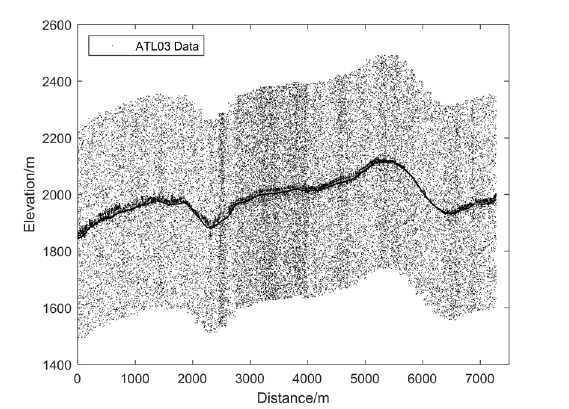
Figure 5 . ATL03 photon data.